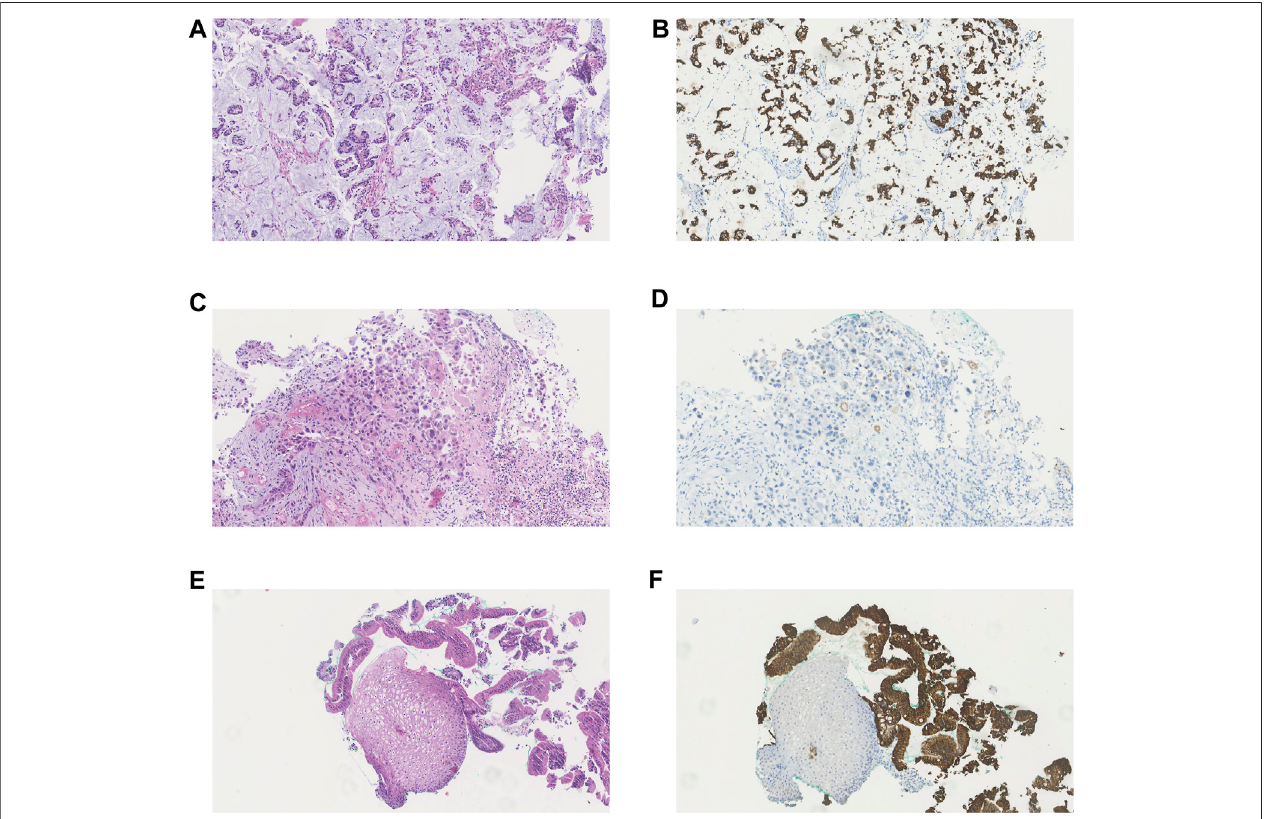
FIGURE 1 | Haematoxylin and eosin (H&E) staining and immunohistochemical staining of ABCB1 in different types of investigated tissue. (A) H&E staining of adenocarcinoma (B) ABCB1immunohistochemicalstainingofadenocarcinoma (C) H&Estainingofsquamouscellcarcinoma (D) ABCB1immunohistochemicalstaining of squamous cell carcinoma (E) H&E staining of healthy esophageal mucosa and Barrett esophagus (F) ABCB1 immunohistochemical staining of healthy esophageal mucosa and Barrett esophagus.